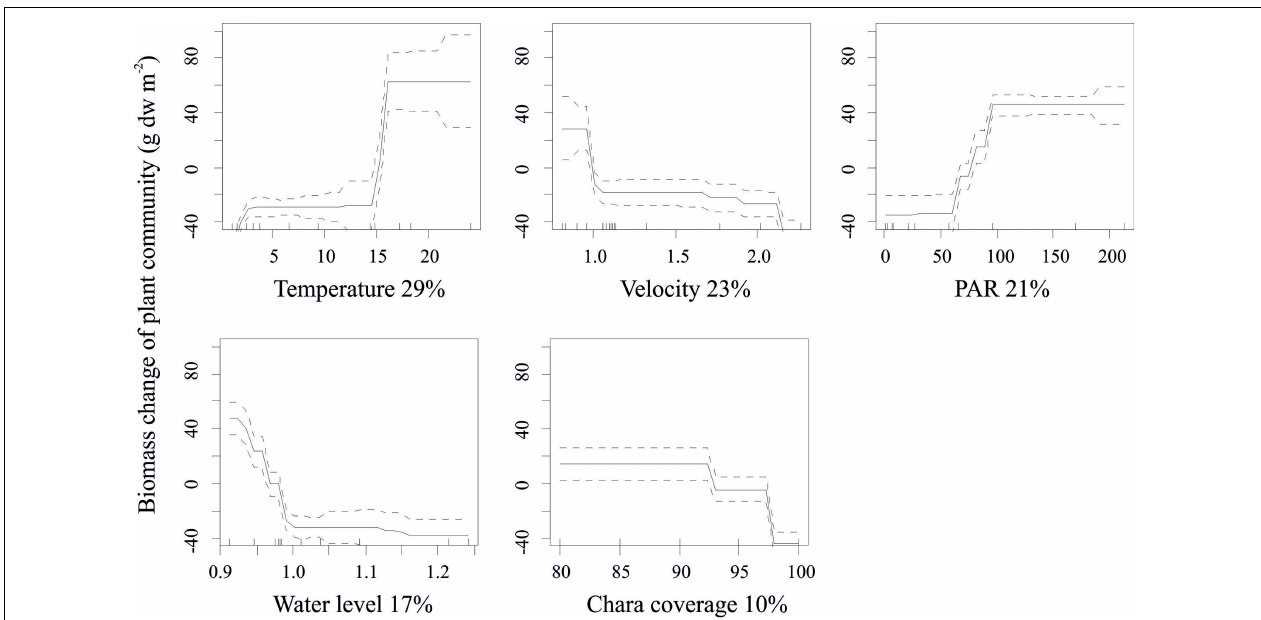
FIGURE 6 | Standardized functional-form relationships ( ± Standard Error) showing the effect of environmental variables on growth in C. aspera biomass, whilst all other variables are held at their means. The variables are ordered by their relative contribution in the BRT model (shown in%). Upward tickmarks on x-axis show the frequency distribution of data along this axis. See the section of methods for further information on environmental